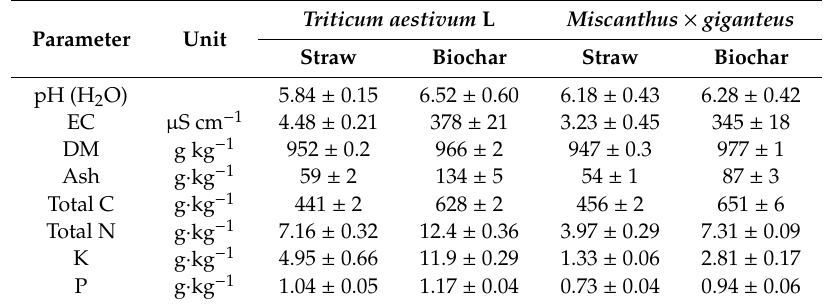
Table 2. Chemical properties of organic amendments used in pot experiment (means ± standard